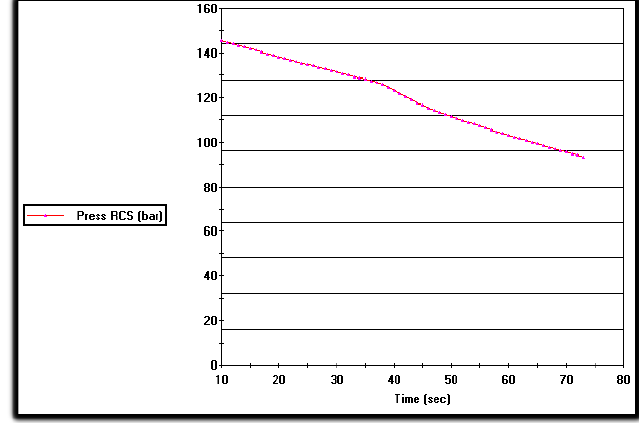
Fig. 19. Transient reactor coolant pressure under